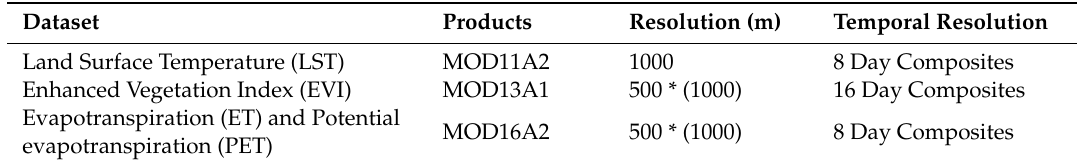
Table 1. Earth observation data used in the study